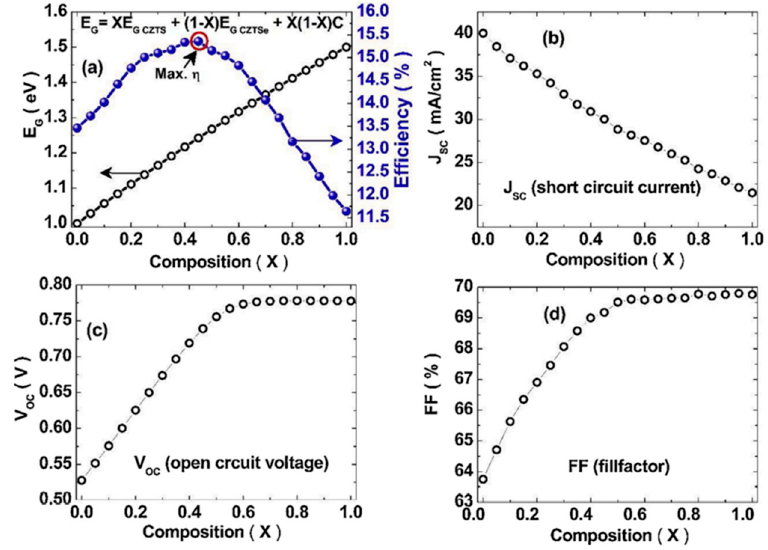
Figure 4. Calculated variation in ( a ) E g and efficiency, ( b ) short circuit current J SC , ( c ) open-circuit V OC , and ( d ) the filling factor (FF) upon the Se content in a Cu 2 ZnSn(S 1 − X Se X ) 4 absorber as calculated by Kumar et al. Reprinted with permission from [8]. Copyright Elsevier.